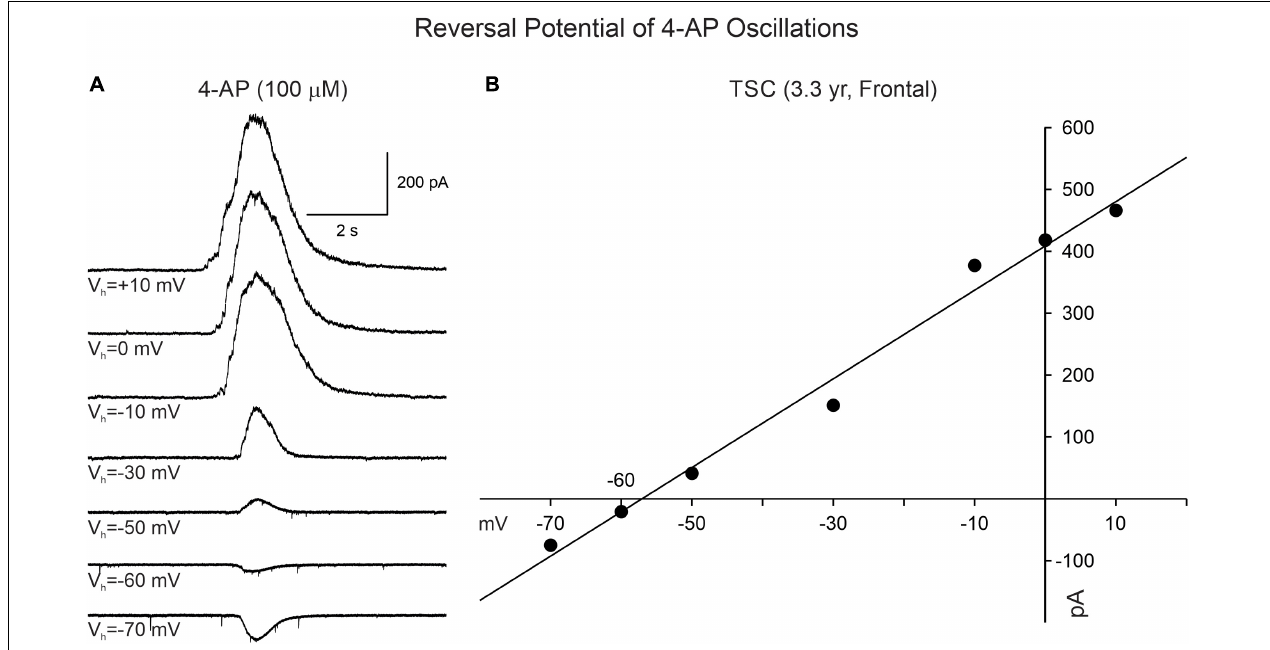
FIGURE 4 | Reversal potential of 4-AP oscillations in CPNs recorded in voltage clamp mode. (A) Traces show voltage clamp recordings of a CPN. After 4-AP oscillations were induced, the holding potential was changed from + 10 to − 70 mV. The amplitude of the 4-AP oscillation decreased from +10 to − 50 mV and reversed between − 60 and − 70 mV. (B) The IV relationship of the 4-AP oscillation determined that the equilibrium potential occurred around − 57 mV, corresponding to the predicted chloride equilibrium potential based on our internal patch solution.